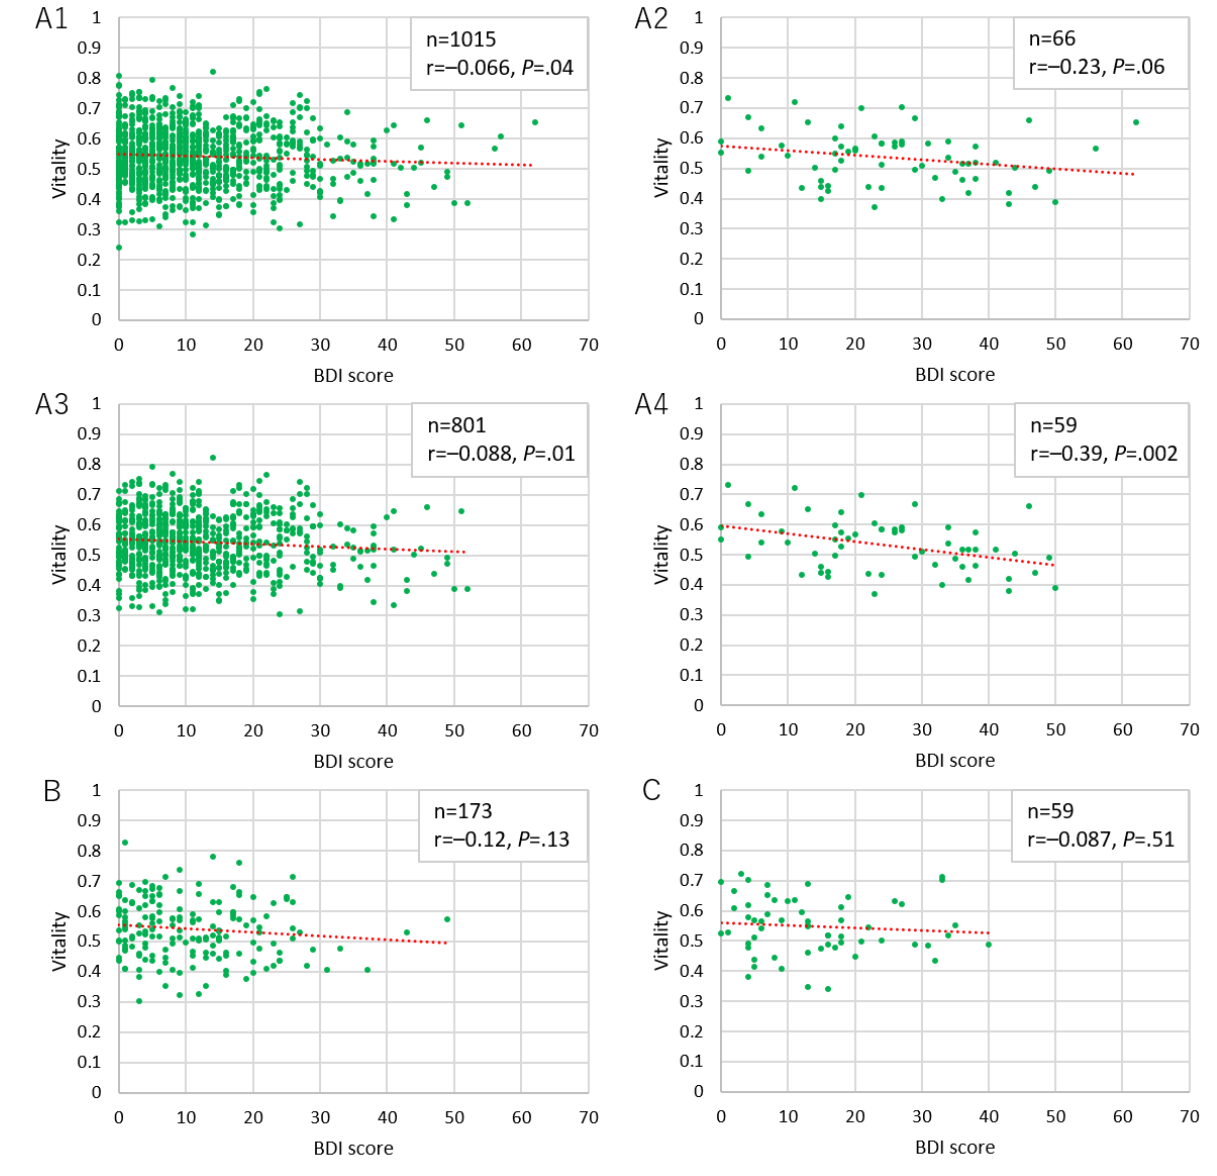
Figure 9. Correlation between Beck Depression Inventory (BDI) score and vitality for